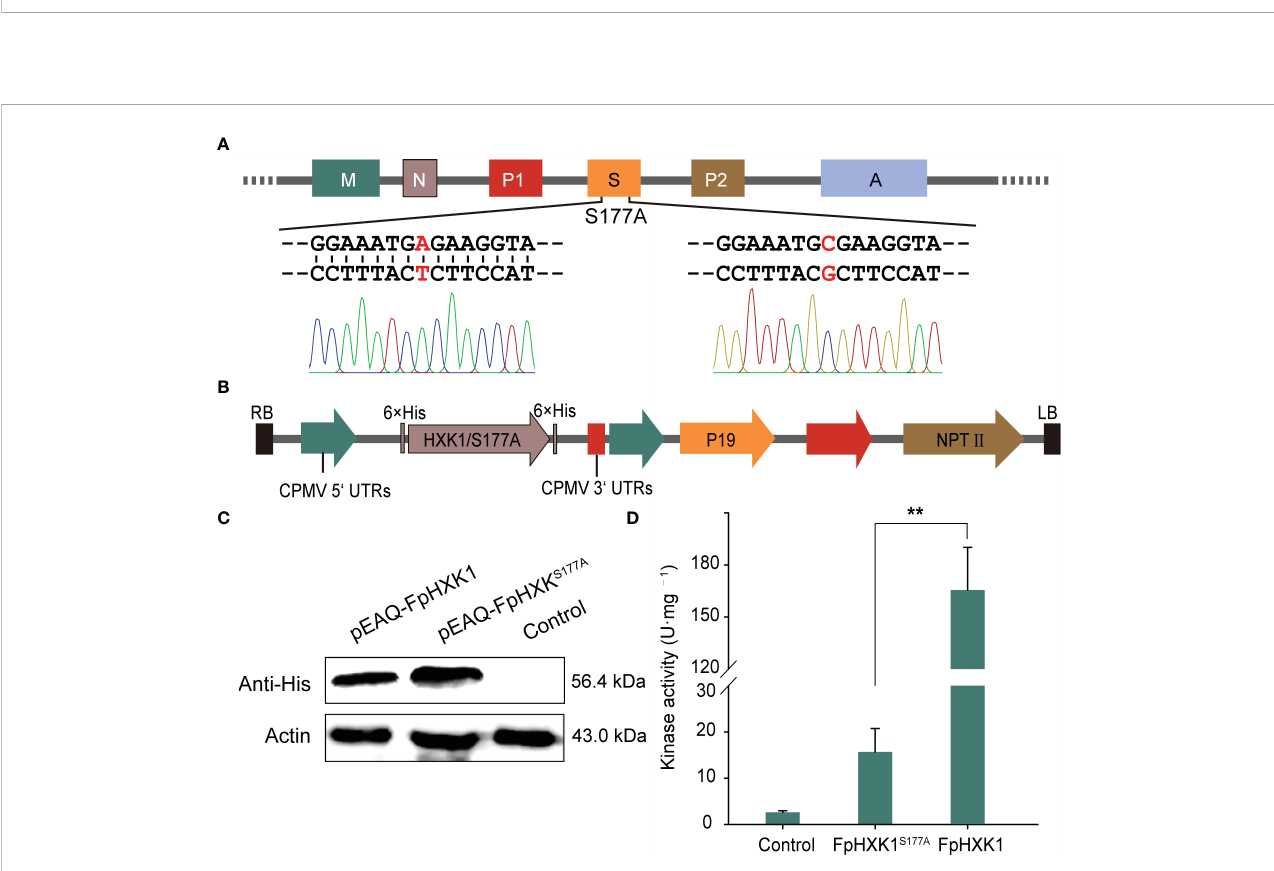
FIGURE 4 Site-directed mutagenesis of FpHXK1 and its impact on the kinase activity. (A) Schematic representation of FpHXK1 and its catalytically inactive mutation site S177A. Mitochondrial targeting signals and NLS are indicated as M and N rectangles. P1 and P2 indicate the conserved phosphate regions 1, and 2. The region S and A indicate the conserved sugar-binding and adenosine-binding domains, respectively. (B) Diagrammatic representation of the T-DNA region of pEAQ-HT (His tag). Black boxes, T-DNA borders; green arrows, promoter sequences; and red arrows, terminator sequences. (C) Western blot analysis of the recombinant protein of FpHXK1 and FpHXK1 S177A in N. benthamiana . (D) Kinase activity assay of the extracts of recombinant FpHXK1 and FpHXK1 S177A . ** indicates signi fi cant difference at the level of p < 0.01.